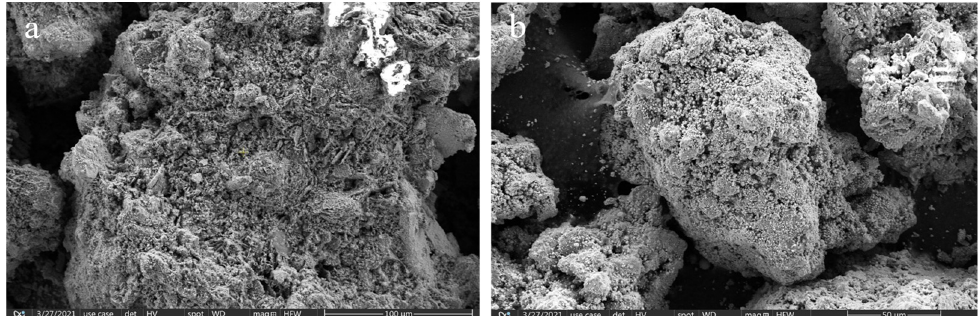
Figure 15. SEM photos of the oxygen carriers: ( a ) fresh sample and ( b ) used sample.